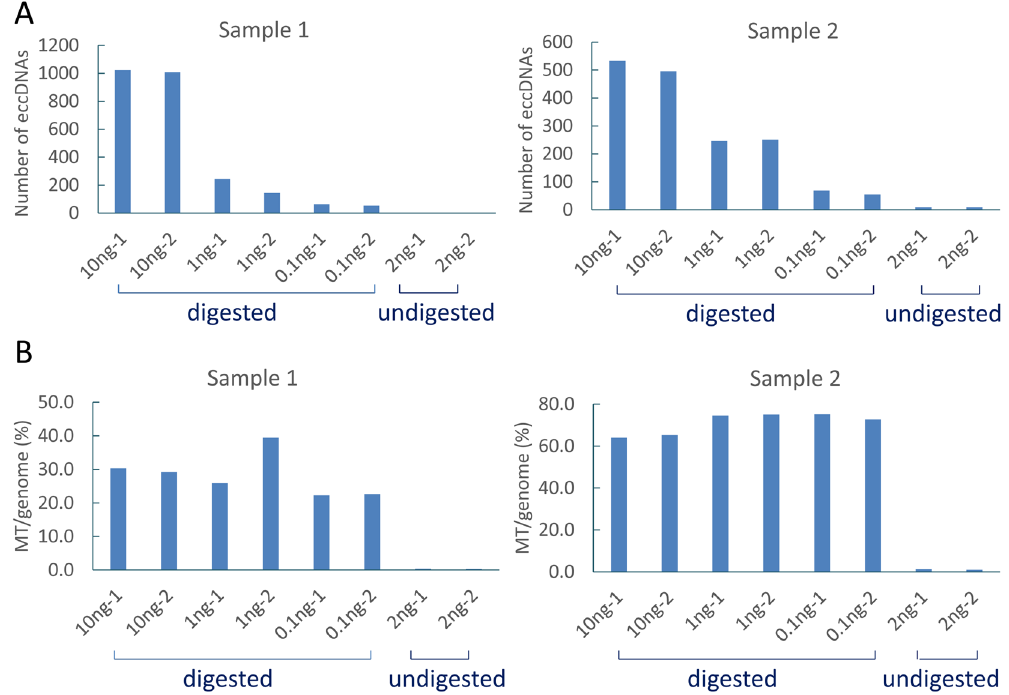
Figure 3. Effect of DNase digestion and initial DNA input on eccDNA detection. ( A ) Number of uniquely detected eccDNAs in different groups in samples 1 and 2. Compared to the digested groups, the undigested groups generated extremely low eccDNAs (3–9 for each assay). In the digested groups, eccDNA detection rate is reduced with the decreasing of initial cfDNA input. ( B ) Ratio between mapped mitochondria and genome sequence reads (MT/genome) in different groups in samples 1 and 2. The ratio of MT/genome decreased significantly in the undigested